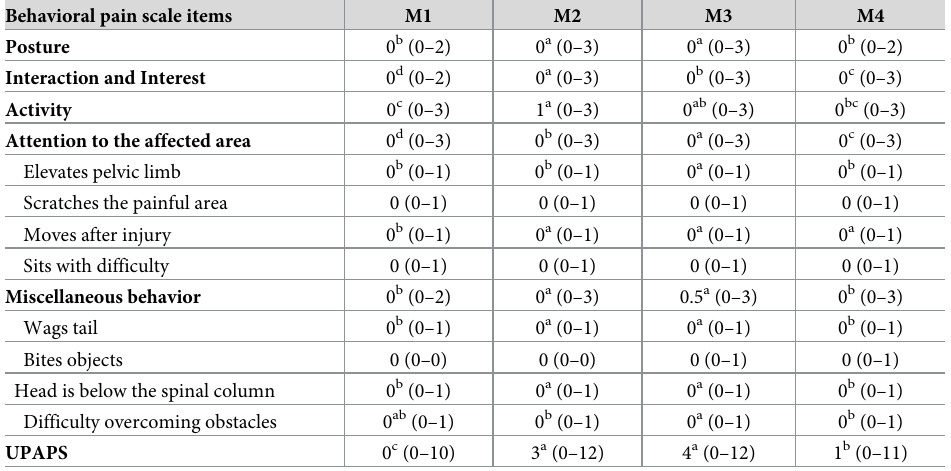
Sits with difficulty Miscellaneous behavior 0 b (0–2) Bites objects Head is below the spinal column Difficulty overcoming obstacles 0 ab (0–1) UPAPS 1 b (0–11)